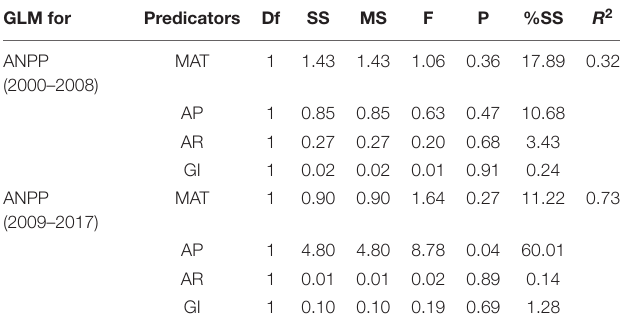
TABLE 1 | Summary of general linear models (GLMs) that included MAT, AP, AR, and GI as predictors for grassland ANPP in the two periods, before and after starting the “Ecological Security Barrier Protection and Construction Project” in Tibet.